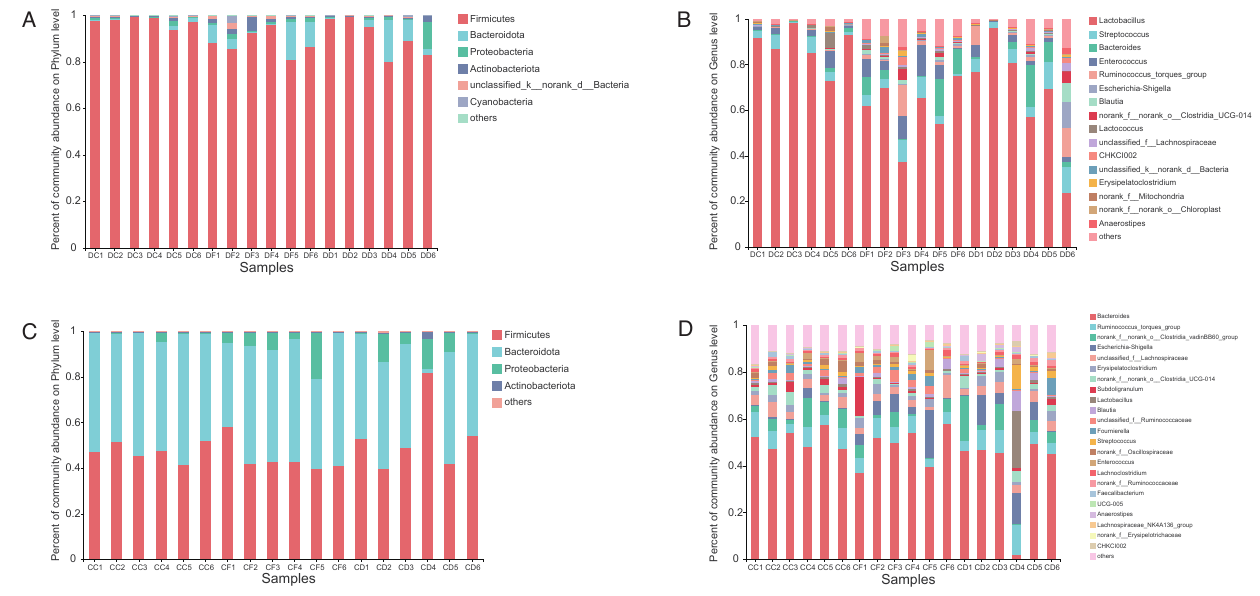
Figure 4. The difference in distribution in the intestinal microbiota at the phylum ( A , C ) and genus ( B , D ) level. Histogram of species composition in the duodenum ( A , B ) and cecum ( C , D ). Species with an abundance of more than 0.02 are listed in each graph, and those with an abundance of less than 0.02 were assigned to “others”. DC, duodenal contents of chickens fed with non-supplemented diet and water; DD, duodenal contents of chickens fed with 0.5% KDF; DF, duodenal contents of chickens supplied with 0.1% KDF in drinking water; CC, cecum contents of chickens fed with non- supplemented diet and water; CD, cecum contents of chickens fed with 0.5% KDF; CF, cecum contents of chickens supplied with 0.1% KDF in drinking